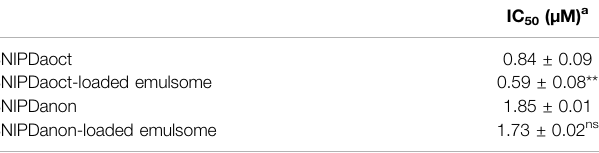
TABLE 2 | The half-maximal inhibitory concentration (IC 50 ) of BNIPDaoct-loaded emulsome and BNIPDanon-loaded emulsome formulations as compared to the value of free forms of BNIPDaoct and BNIPDanon (IC 50 values for 72 h of treatment of Leishmania infantum